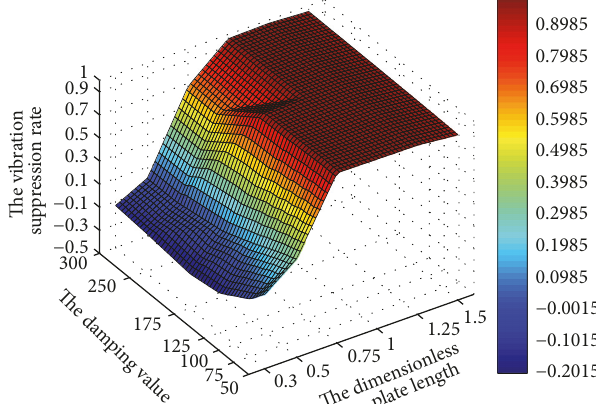
Figure 10: Three-dimensional surface cloud diagram of variation of the vibration suppression